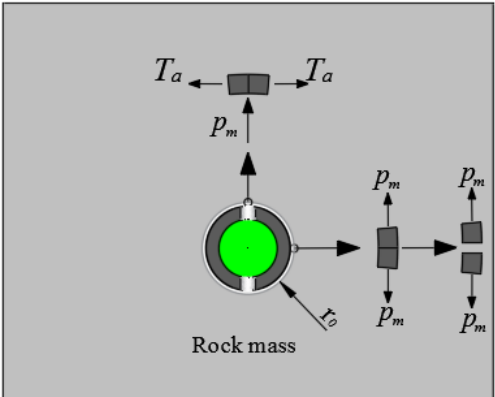
Figure 1. Diagram of initial crack propagation on the borehole wall without confining pressure.